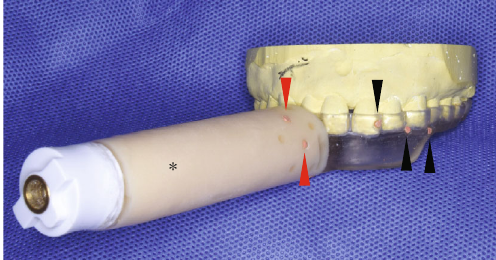
Figure 5: A custom-made splint. The 10cm resin handle (with a connector), which was used to fi x the reference frame ( ∗ ) and the gutta-percha markers are placed in asymmetric positions into both the splint (black arrowheads) and resin handle (red arrowheads) for marker-based pair-point registration.